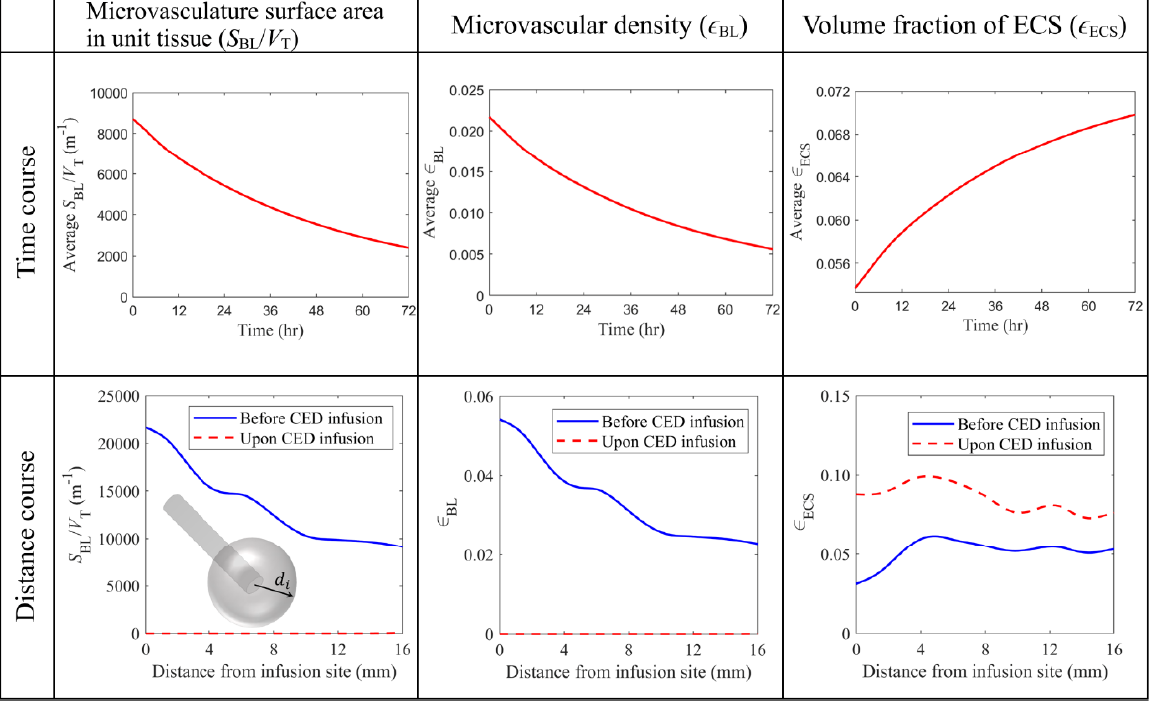
Figure 8. Comparison of tissue biological properties before and upon the combined CED infusion. The time course graphs in the top row are plotted using the average values in the entire brain tumor. The results taken on Day 3 are used to plot the distance course graphs in the bottom row.